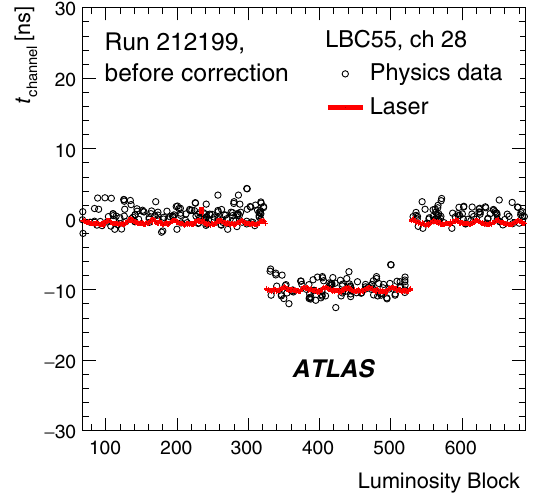
Fig. 6 An example of timing jumps detected using the laser (full red circles) and physics (open black circles) events (left) before and (right) after the correction. The small offset of about 2ns in collision data is